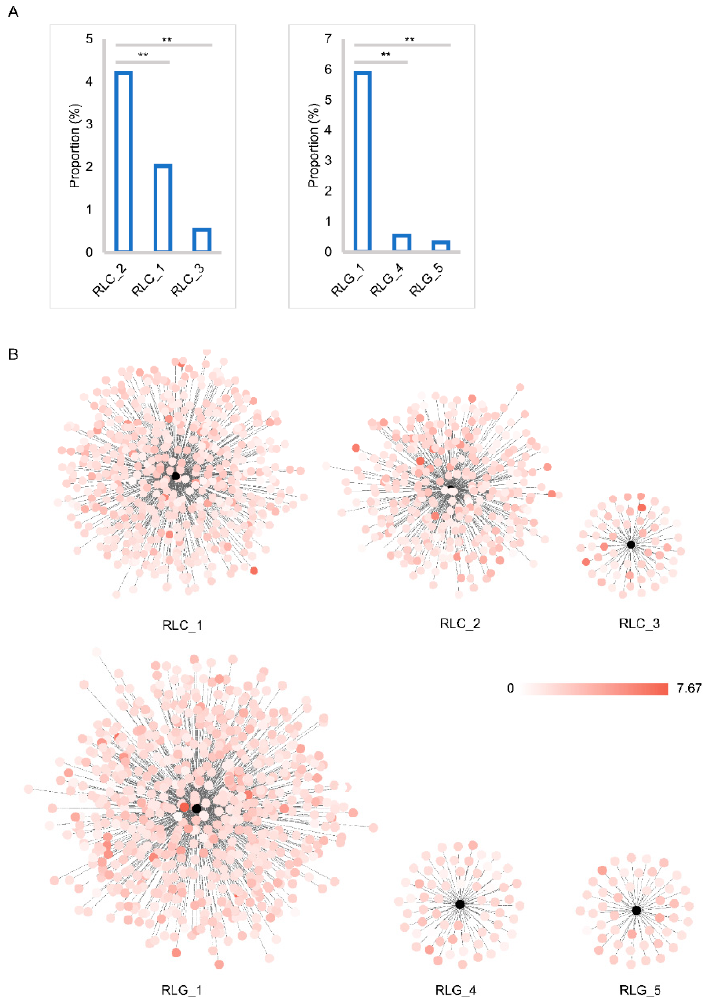
Figure 6. Insertion time and proportion analysis of each of three representative families of the Copia and Gypsy superfamilies. ( A ) proportional analysis of three representative families of the Copia (RLC_2, RLC_1, and RLC_3) and Gypsy (RLG_1, RLG_4, and RLG_5) superfamilies; The x -axis represents the families. The y -axis represents the proportion of the genome occupied by each family. ( B ) insertion time analysis of three representative families of the Copia (RLC_2, RLC_1, and RLC_3) and Gypsy (RLG_1, RLG_4, and RLG_5) superfamilies. Cytoscape (version 3.6.1) was used to construct the figure with yFiles layout model. Every black plot means a corresponding family. Other plots, whose colors range from white to red and are linked to the black plot, denote each member of the corresponding family. The insertion times of each member of one family were denoted by the colors of the plots. Color bar represents the insertion time range: 0 to 7.67